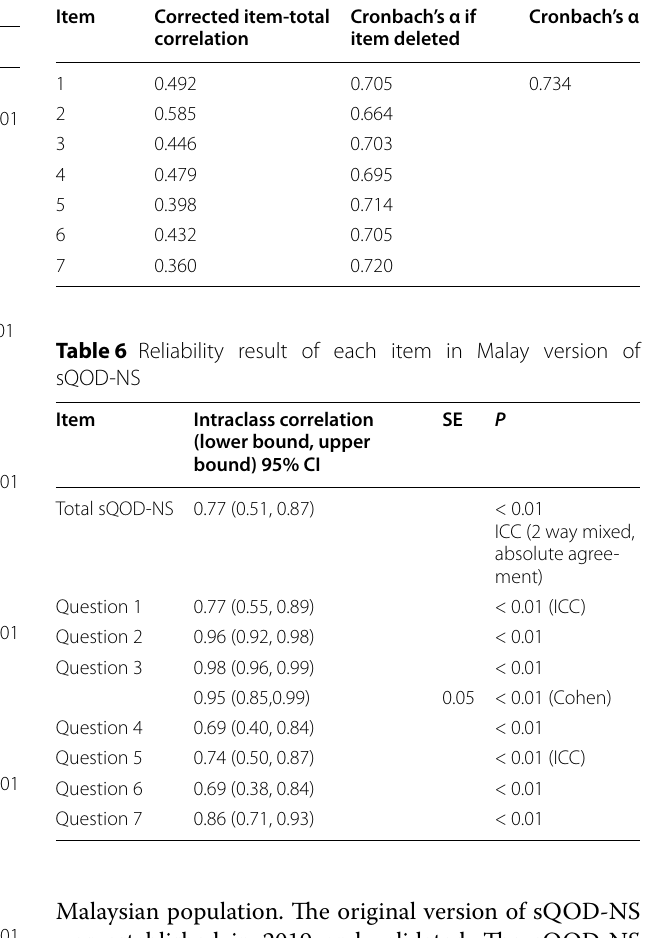
Table 5 Internal consistency of sQOD-NS